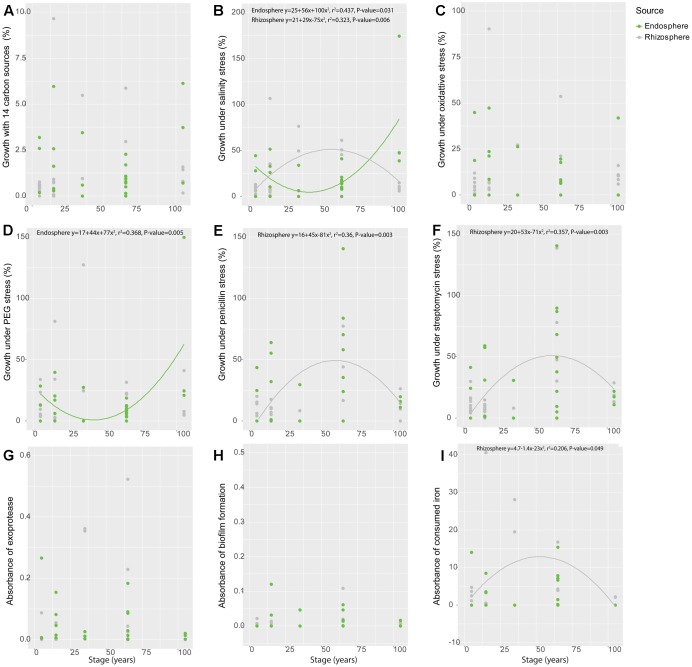
Variation of functional traits of bacterial isolates from rhizosphere and endosphere along the chronosequence. (A) Metabolic potential, (B) Salinity stress resistance, (C) Oxidative stress resistance, (D) Osmotic stress resistance, (E) Penicillin resistance, (F) Streptomycin resistance, (G) Exoprotease production, (H) Biofilm production and (I) Siderophore production. Gray color refer to rhizosphere isolates whereas green represent those obtained from the endosphere.